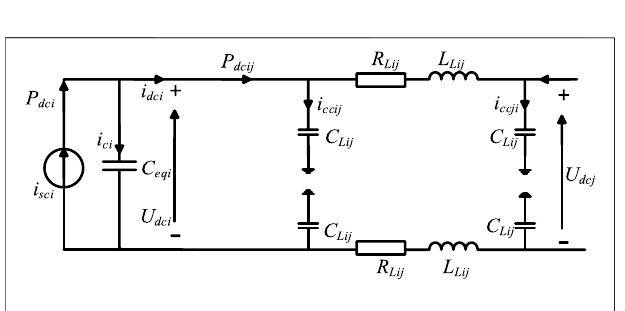
FIGURE 10 | Equivalent circuit of the